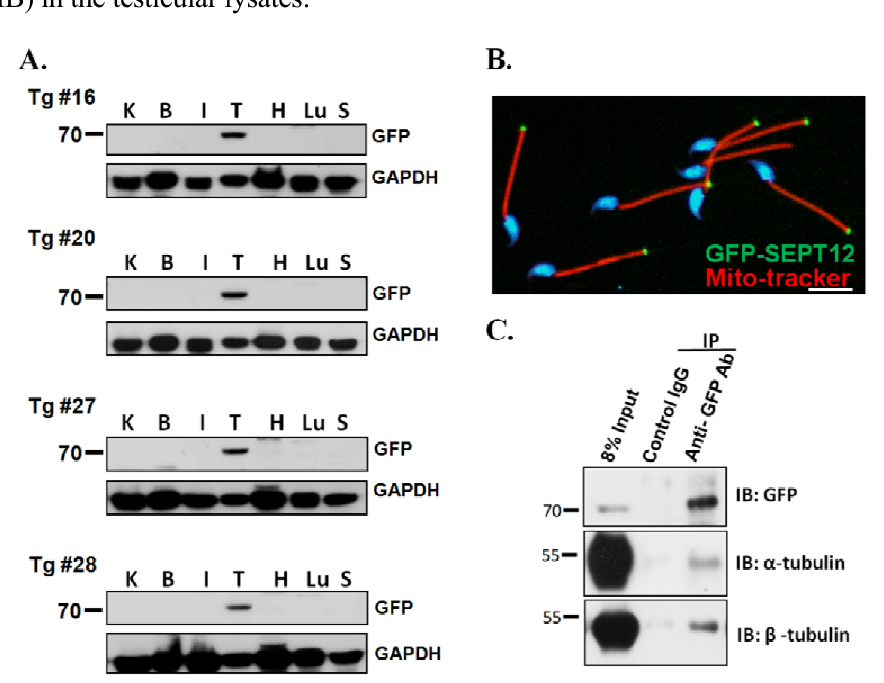
Figure 2. Expression of SEPT12, α - and β -tubulin in the SEPTIN12 -transgenic mice. ( A ) SEPT12 expression in different organs from the SEPTIN12 -transgenic mice. The tissue lysate from kidney (K), brain (B), intestine (I), testis (T), heart (H), lung (L) and spleen (S) were analyzed by Western blotting with anti-GFP or anti-GAPDH antibody (loading control); ( B ) Spermatozoa isolated from vas deferens of SEPTIN12 -transgenic mice were stained with mito-tracker (Red), DAPI (Blue) and SEPT12 (Green); Scale bar: 5 μ m; ( C ) Co-IP of GFP-SEPT12 and α - or β -tubulin. Testicular lysates from SEPTIN12 -transgenic mice were immunoprecipitated (IP) with anti-GFP antibody (lane3) followed by immuno-blotting (IB) with anti-GFP, anti- α -tubulin and anti- β -tubulin antibody, respectively. IgG was used as control. Input protein (8%) was used as control of immuno- blotting (IB) in the testicular